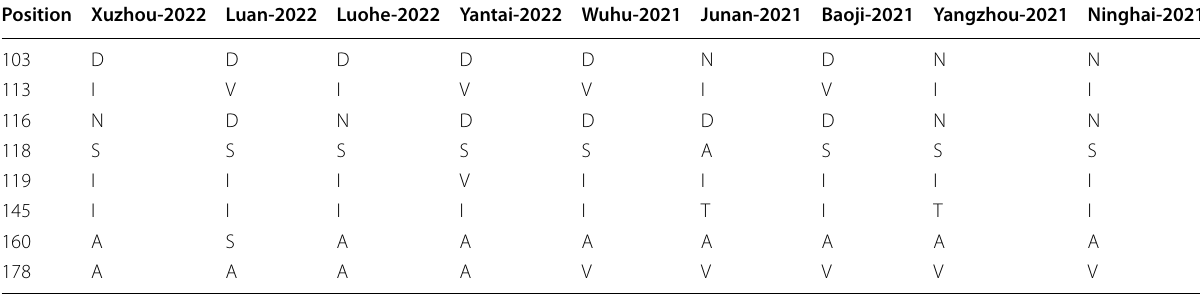
Table 1 Consensus amino acids at 7 positions in the wheat yellow mosaic virus coat protein amino acid sequence alignment for the virus isolates from various sampling areas in